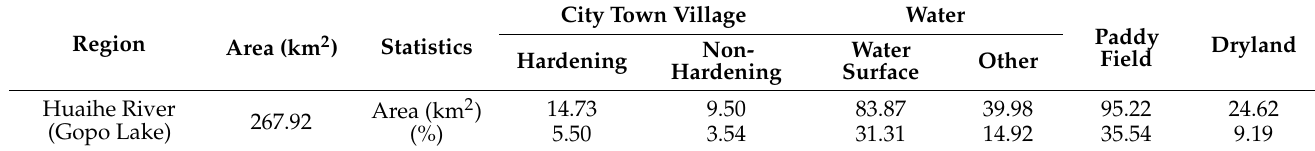
Table 1. Pilot area (cid:48) s statistical table of underlying surface conditions (2019).